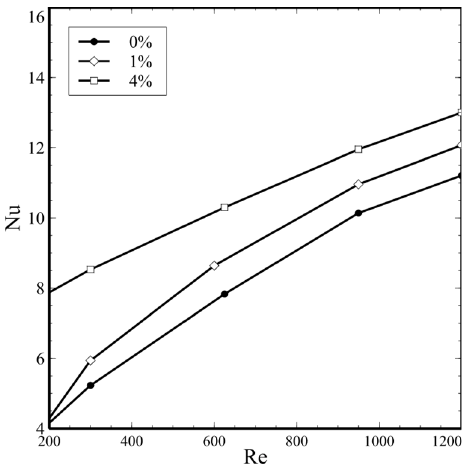
Figure 4. Comparison of Nu for an Al 2 O 3 -water nanofluid at 𝜙 (cid:3029) = 0%, 1% and 4%.